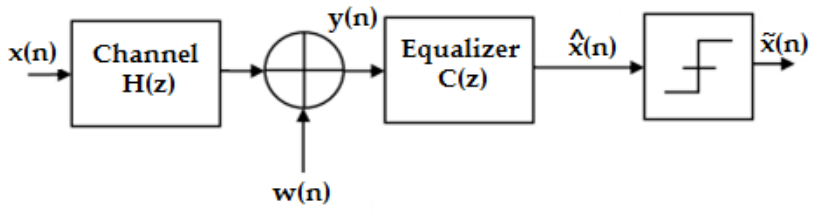
Figure 4. Diagram of a linear equalizer